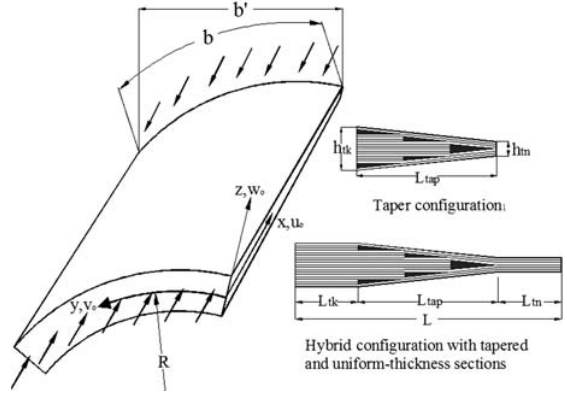
, v , w ), that refers to the o o o and ϕ denote k y